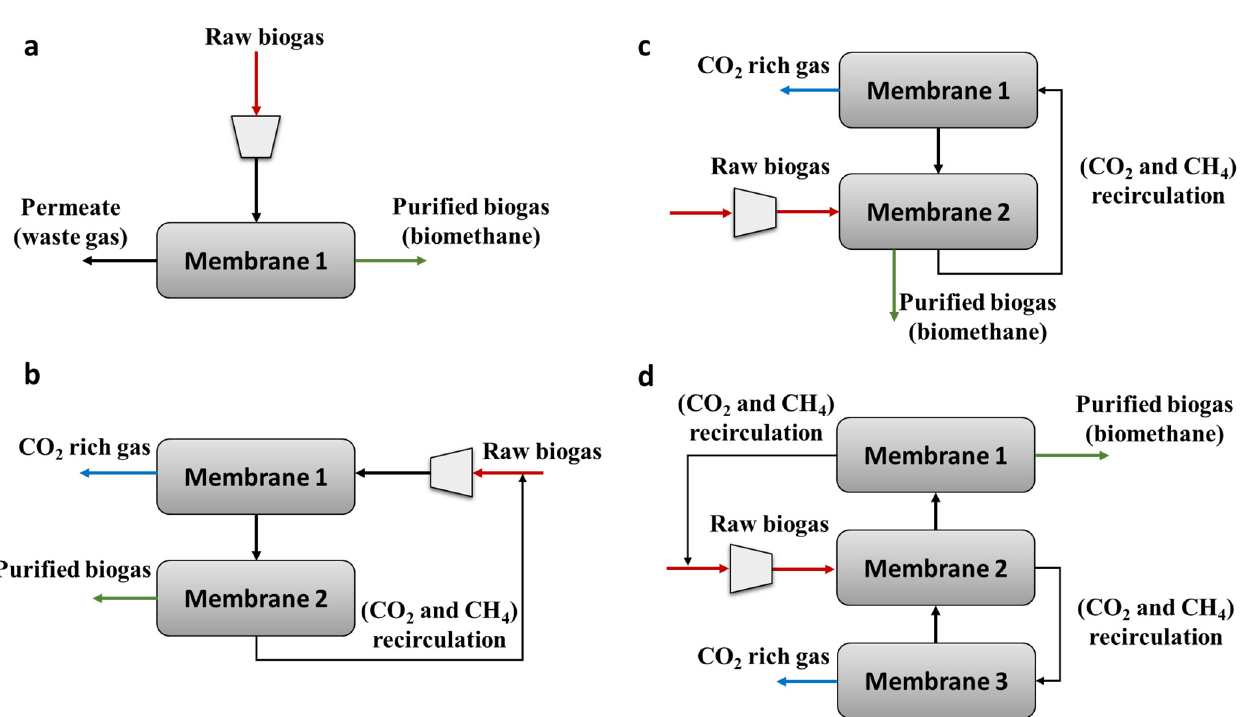
Figure 15. Different design configurations for biogas upgrading ( a ) single-stage configuration, ( b ) two-stage configuration with a recirculation loop, ( c ) two-stage configuration with sweep and ( d ) three-stage configuration with sweep. Adapted from Angelidaki and co-workers, 2018, and Bauer and co-workers, 2013.